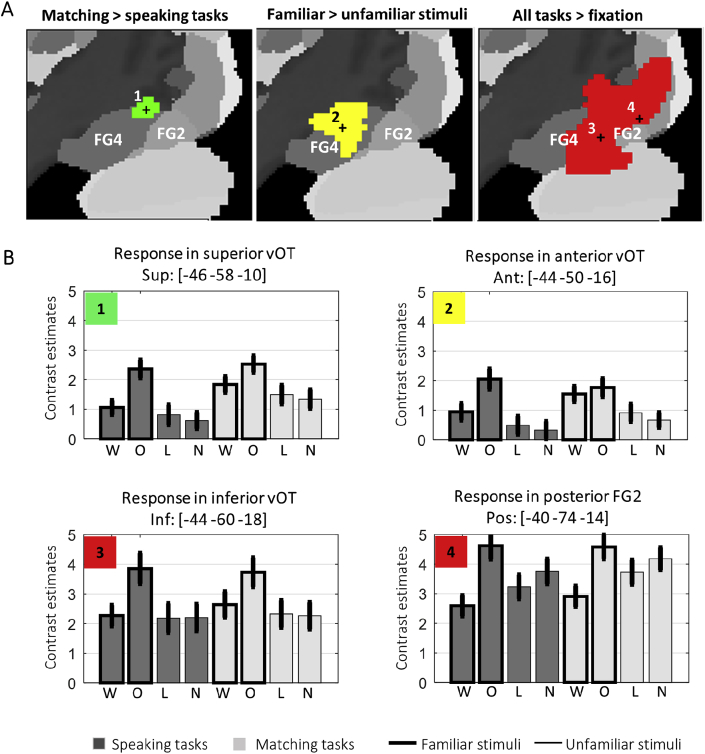
Activation findings. (A) Activation for matching versus speaking tasks (green), familiar versus unfamiliar stimuli (yellow), and all tasks versus fixation baseline (red), projected on a sagittal view (at x ​= ​−44mm) of the Anatomy Toolbox's cytoarchitectonic maps in MNI space. (B) Brain activation (effect size) for all eight task conditions at the peak voxels for: the task effect in superior vOT [-46, −58, −10]; the familiarity effect in anterior vOT [-44, −50,-16], and all conditions compared to fixation in inferior vOT [-44,-60,-18] and posterior fusiform [-40, −74, −14]. The bars report average activation estimates with error bars indicating 90% confidence intervals. Abbreviations: W ​= ​words, O ​= ​objects, L = (Greek) letters, N ​= ​nonobjects, FG2 and FG4 ​= ​cytoarchitectonic areas of the Anatomy Toolbox, ‘+’ ​= ​location of the peaks of interest used in the plots below.